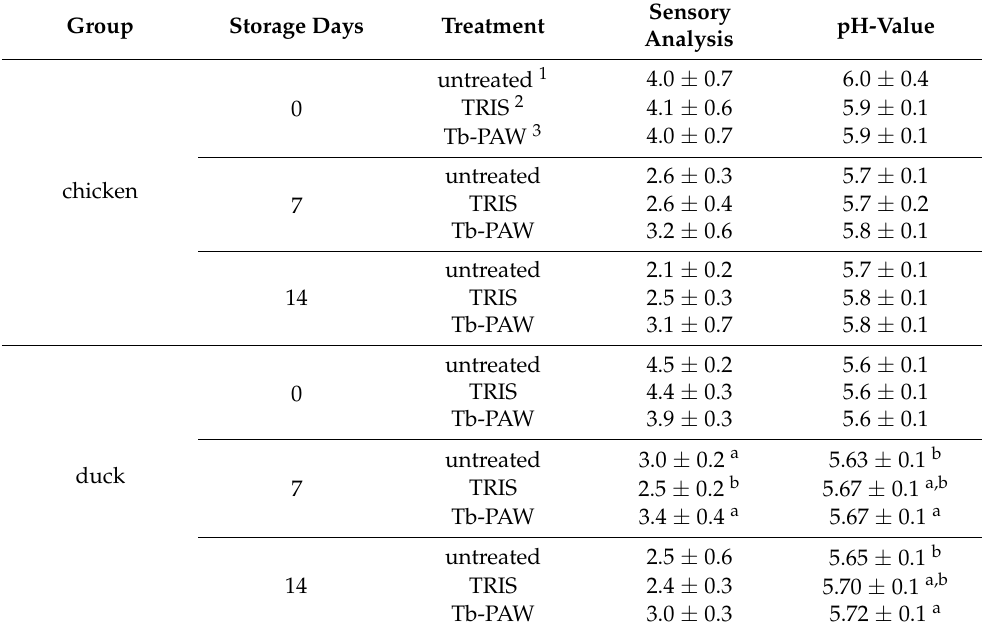
Table 1. Sensory acceptability (rated by three test persons) and the pH-values of chicken and duck breast meat and skin treated with or without Tb-PAW or TRIS-buffer depending on the day of storage (0, 7, 14) in modified atmosphere packages (30% CO 2 , 70% N 2 ). Results represent the mean ± standard deviation. (N = 3). Sensory pH-Value Group Storage Days Treatment Analysis untreated 1 4.0 ± 0